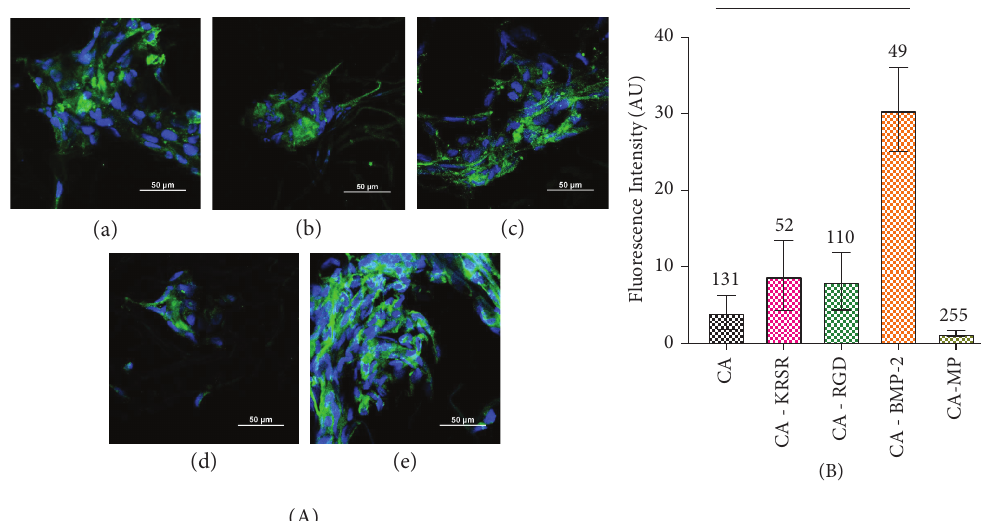
Figure 3: (a) α V β 3 integrin expression (green) in hFOB 1.19 (blue nuclei) across each CA electrospun mat. (A) CA fiber mat, (B) CA-KRSR, (C) CA-RGD, (D) CA-BMP-2, and (E) CA-MP. Scale bar represents 50 µ m. (b) Fluorescence intensity across samples normalized by the total cells displayed over each